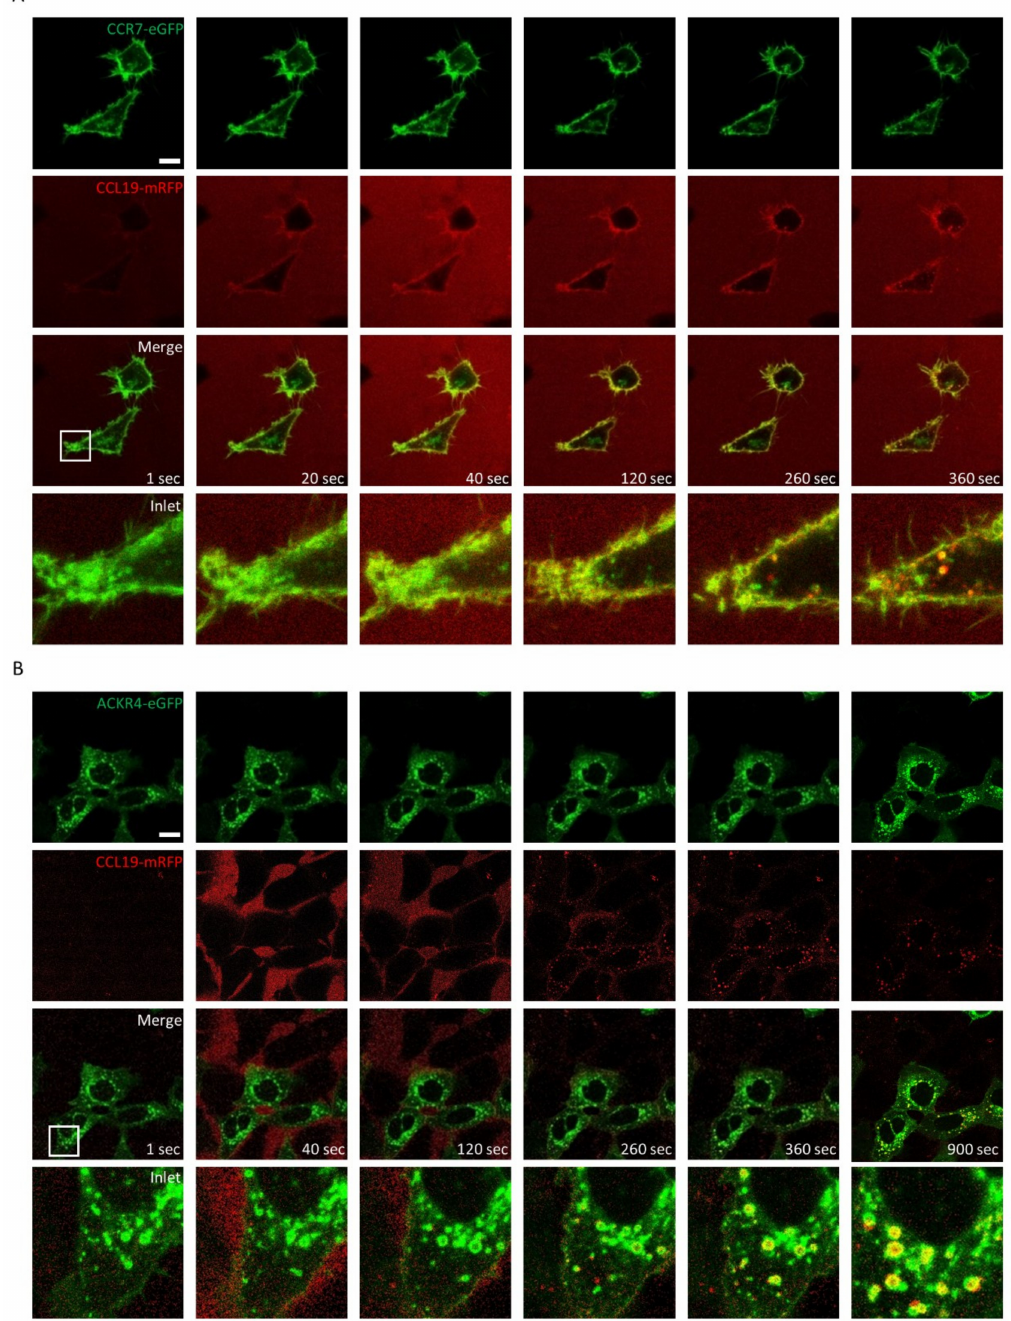
Figure 3. Internalization of CCL19-mRFP by CCR7-eGFP and ACKR4-eGFP. 100 nM of CCL19-mRFP was added to HEK293 cells transiently transfected with CCR7-eGFP ( A ) or ACKR4-eGFP ( B ) and CCL19-mRFP internalization was recorded by time-lapse video microscopy. Series of images captured at indicated time points are illustrated (scale bar: 10 µ m). Frames: magnification of